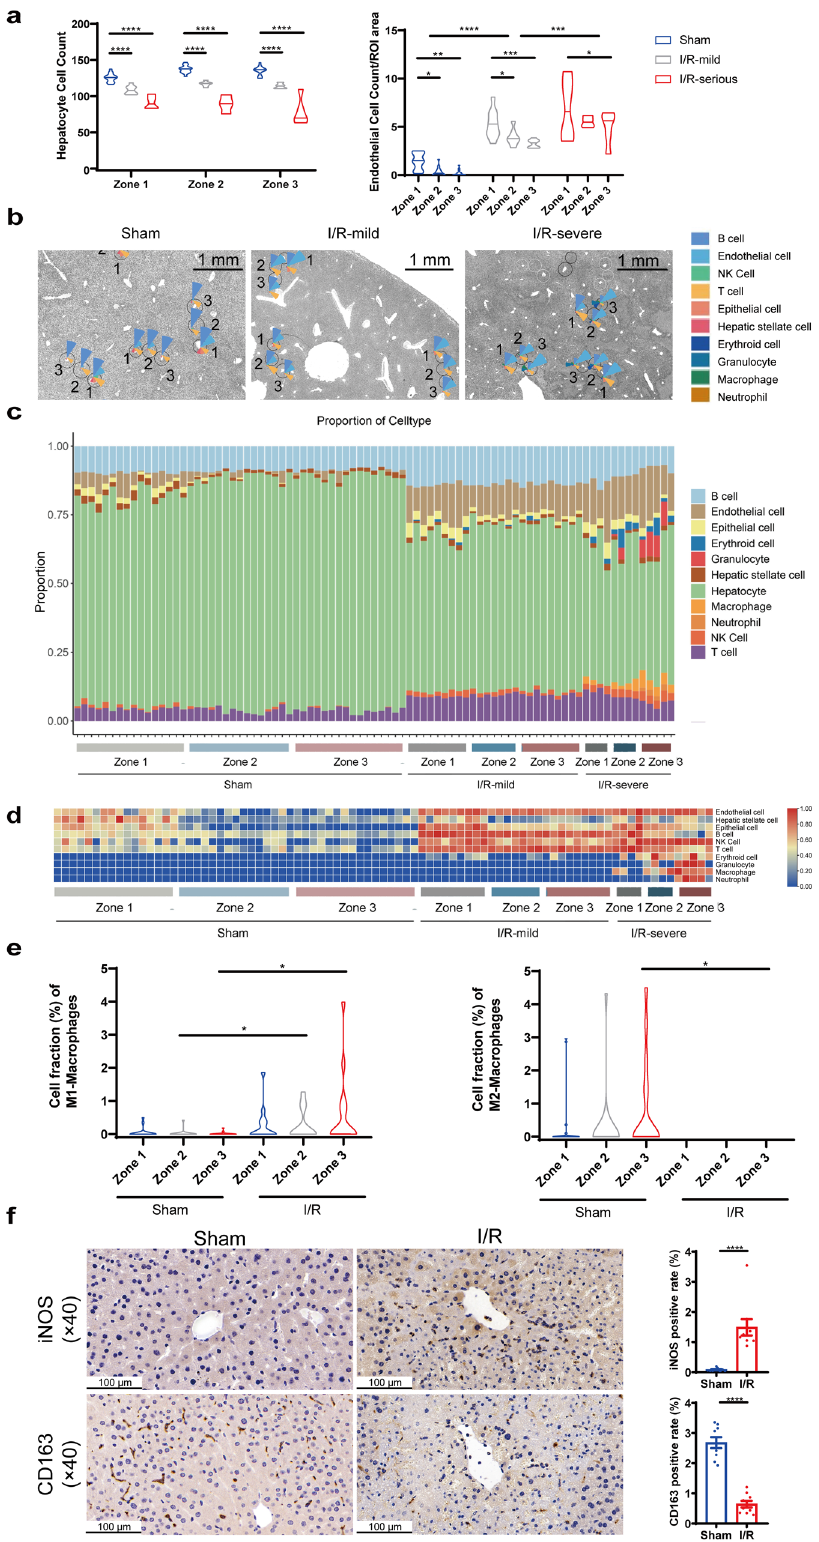
Fig. 4 I/R-induced alterations in the proportion and abundance of hepatocytes and hepatic NPCs. a The cell count and proportion of hepatocytes and normalized endothelial cells content of sham and I/R groups (two-way ANOVA, n = 15 – 16 for the sham group, n = 7 – 9 for I/R mild regions and n = 4 – 5 for I/R severe regions, * p < 0.05, ** p < 0.01, *** p < 0.001, **** p < 0.0001, center lines indicate median value). b – d Proportion of hepatocytes and hepatic NPCs of sham and I/R groups. e Zonal distribution of cell fraction of M1- and M2-macrophages in sham and I/R group (Student ’ s t-test, n = 11 – 16, * p < 0.05). f IHC staining and quanti fi cation of M1-macrophages marker iNOS and M2-macrophages marker CD163 (Student ’ s t-test, n = 9, **** p <